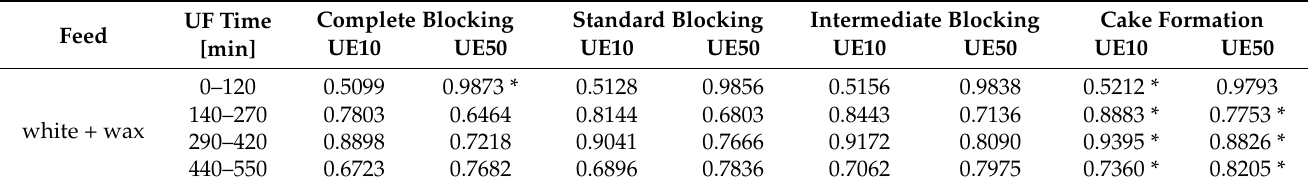
Table A3. Coefficient of determination (R 2 ) Hermia’s model. The wastewater concentration by the UF process (Figure 10).